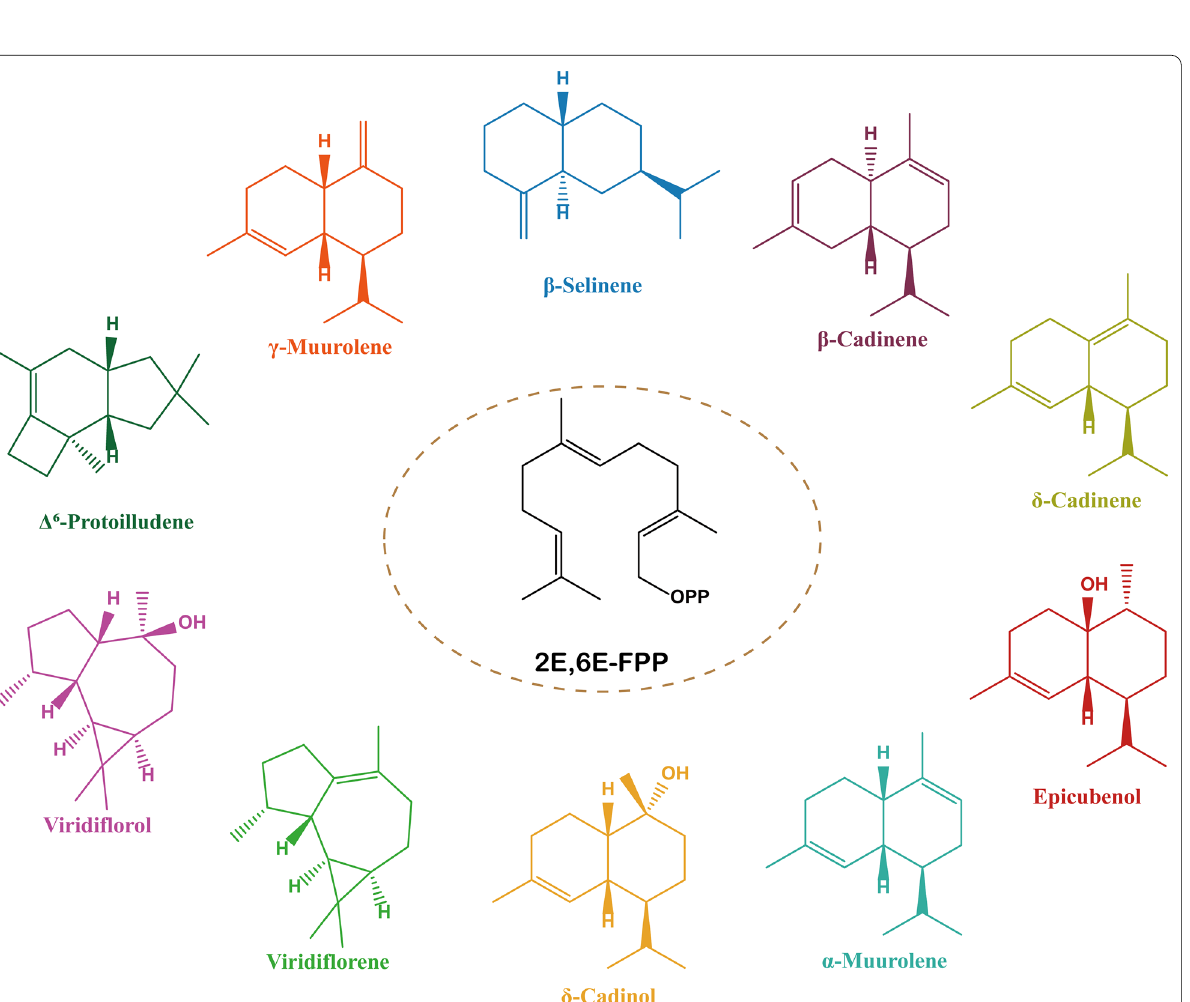
Fig. 5 Terpenes produced by E. coli expressing STS genes from A.